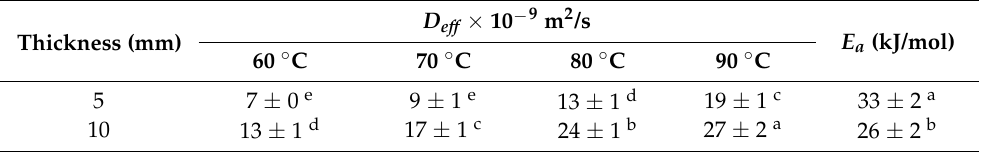
Different lowercase letters (a, b, c, d, and e) within the same row represent statistically significant differences at 5%